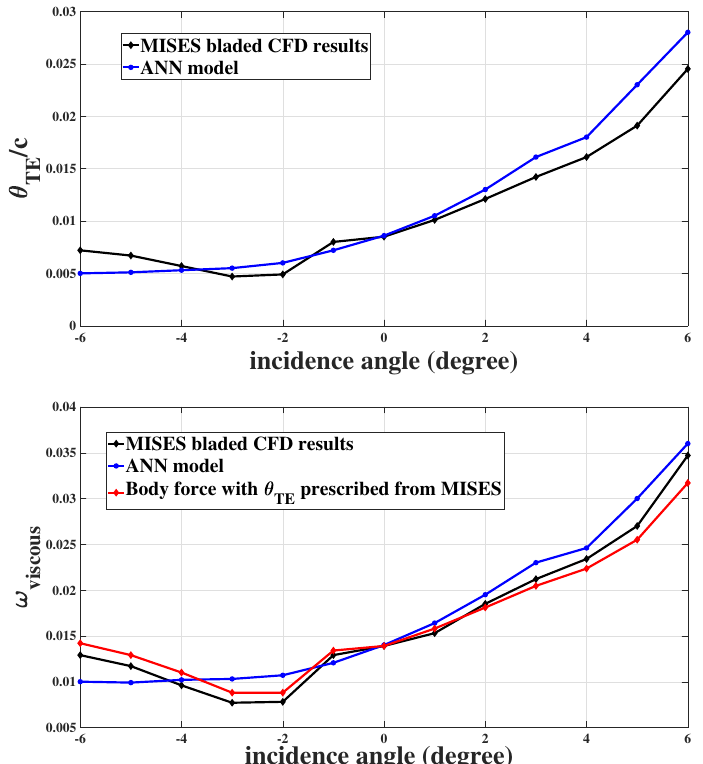
Figure 7. Comparison of trailing edge momentum thickness ( top ) and loss coefficient ( bottom ) from MISES and ANN model for cascade 1 ( σ = 1.0, M ∞ = 0.3, Re = 3.35 × 10 5